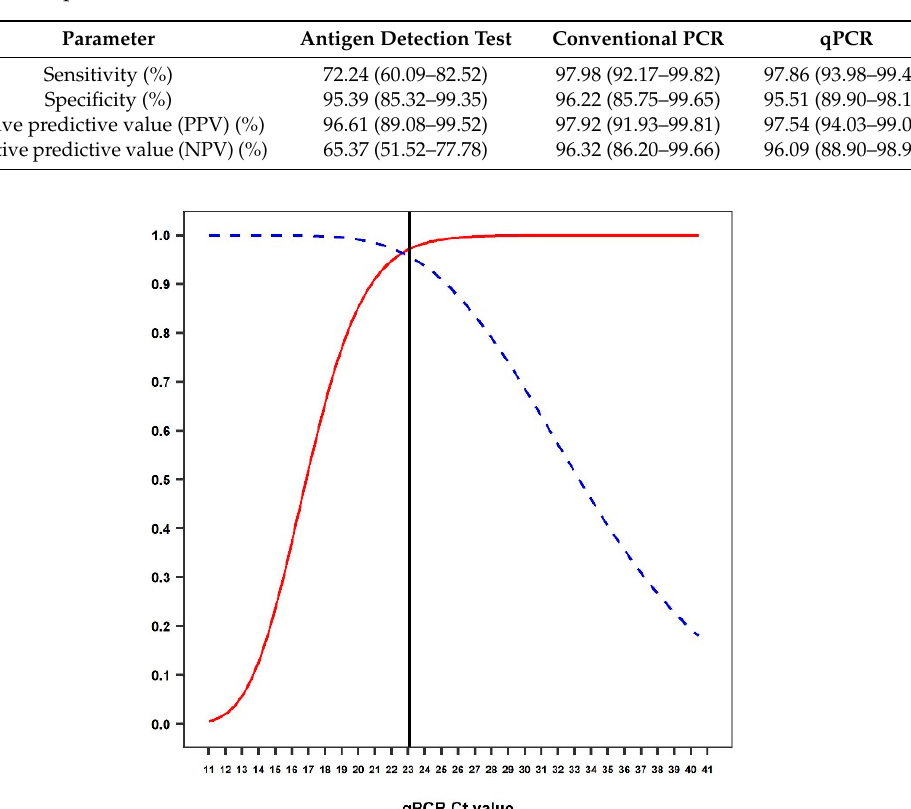
Figure 2. Two-graph receiver operating characteristic curve (TG-ROC) as obtained from Bayesian latent class analysis of Ct values for faecal samples on quantitative PCR (qPCR) test. The dashed and solid lines represent specificity and sensitivity, respectively. The cut-off was chosen at a Ct value of 23.10 (vertical solid line).